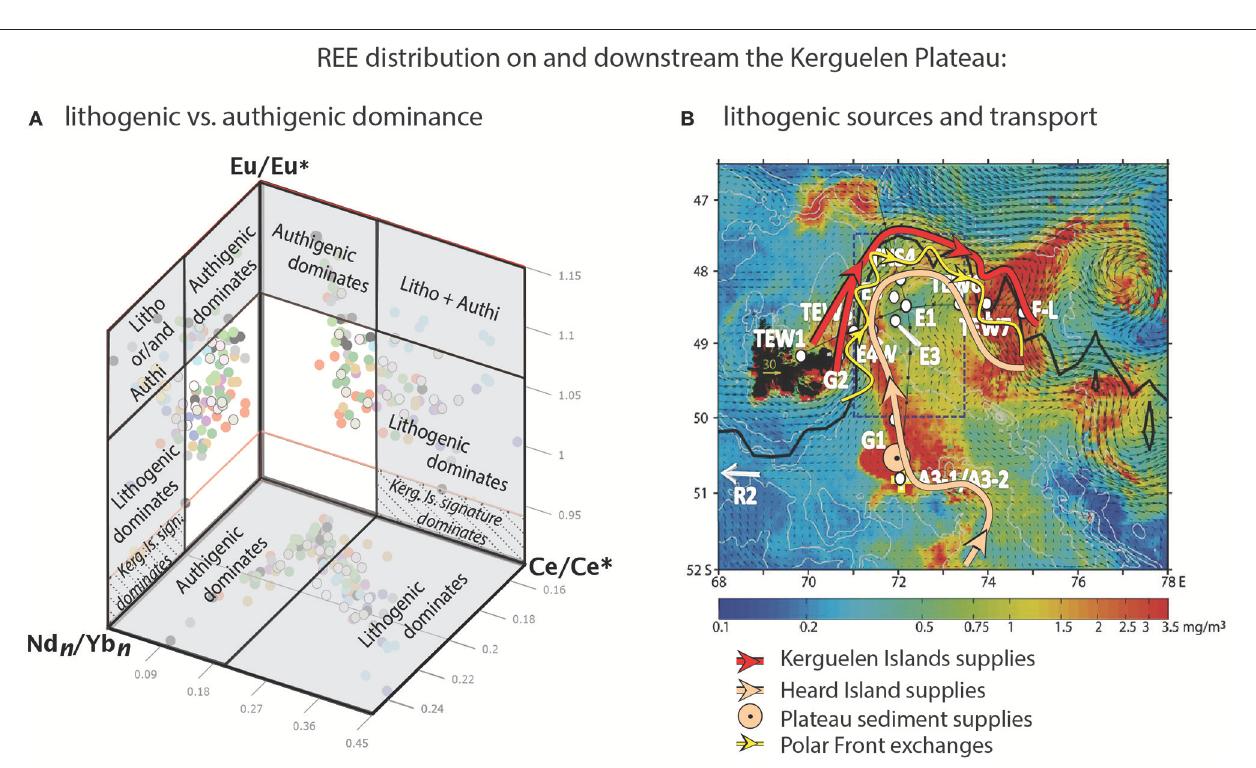
FIGURE 11 | Synthesis of the main processes that control the REE distribution in the Kerguelen Plateau area: (A) schematic summary of Figure 6 identifying the dominance of lithogenic vs. authigenic processes in REE fractionations; (B) schematic representation of the different sources of lithogenic material -Kerguelen Islands, Heard Island, Central Plateau sediments- and their transports via the different oceanic pathways identified in Park et al. (2014), north of, south of, and across the Polar Front.